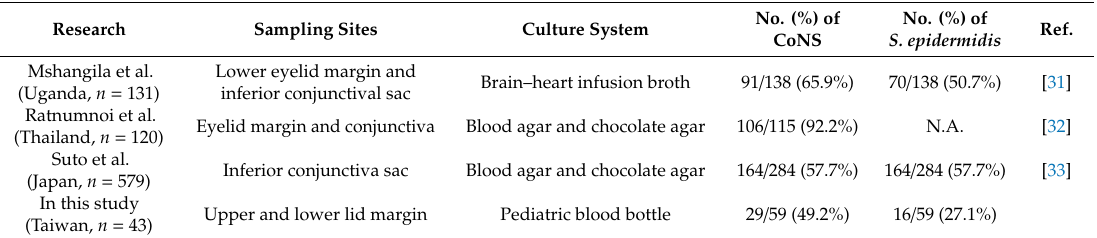
Table 3. Comparison of the Isolated Number of Cultured CoNS on Ocular Surface in Similar Research